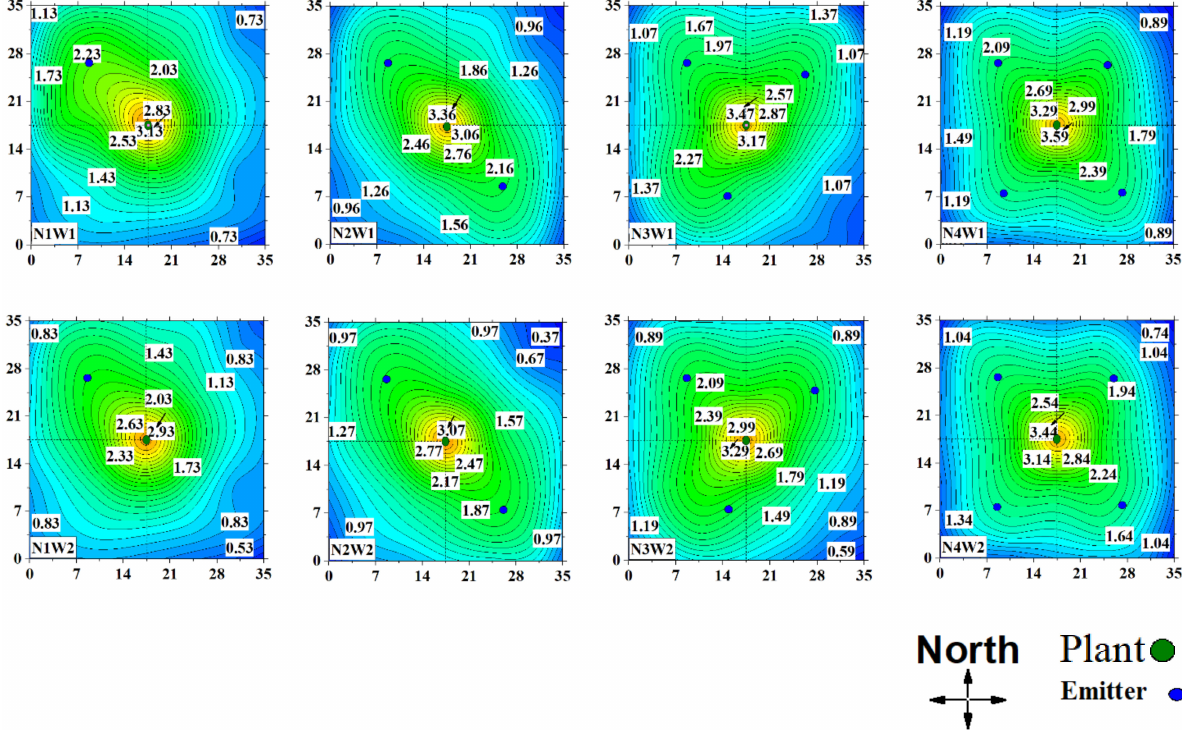
Figure 5. Effects of emitter density and irrigation levels on horizontal root length density (RLD, cm cm − 3 ) distribution for the fall-winter cropping season (at the end of the cropping season; the maximum value is marked by a solid